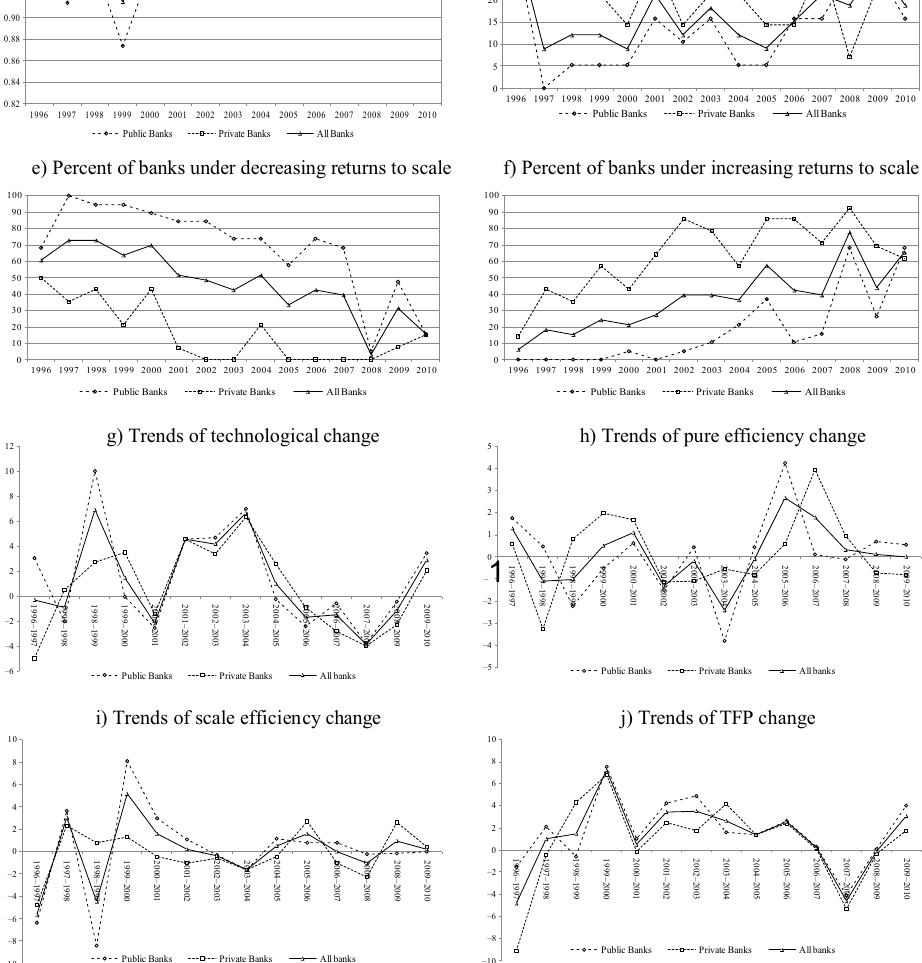
Fig. 1. Trends of performance indicators in Indian banking